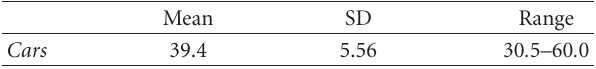
Table 3: Descriptive statistics of CARS